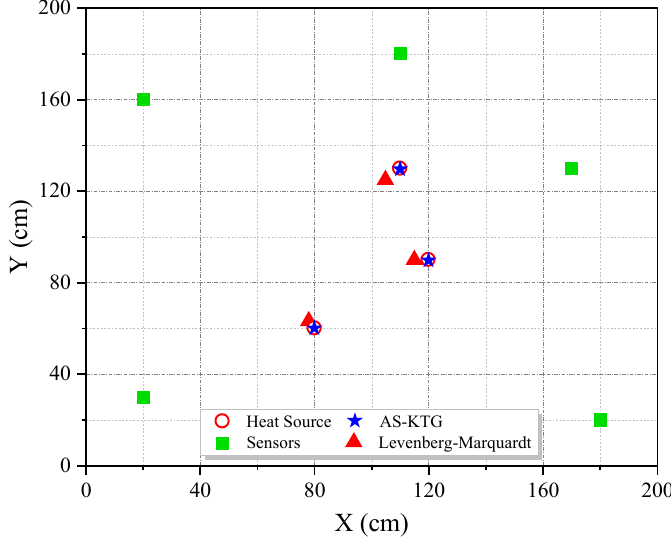
Figure 2. Locations of receivers and calculated results of AS-KTG and inverse results by Levenberg–Marquardt.